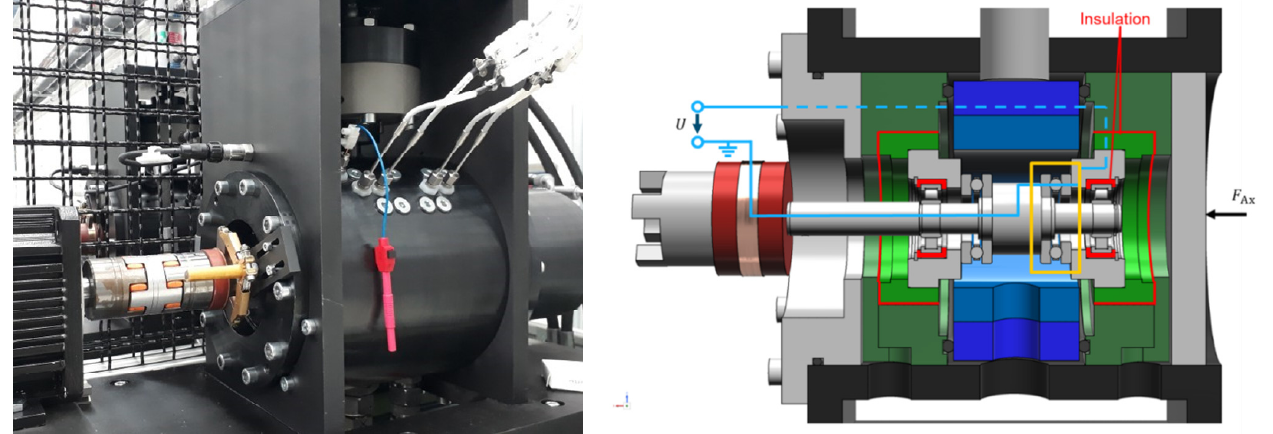
Figure 2. ( left ): Testing cell of the bearing test rig at the Technical University of Darmstadt; ( right ): sectioning and current path of the testing cell.